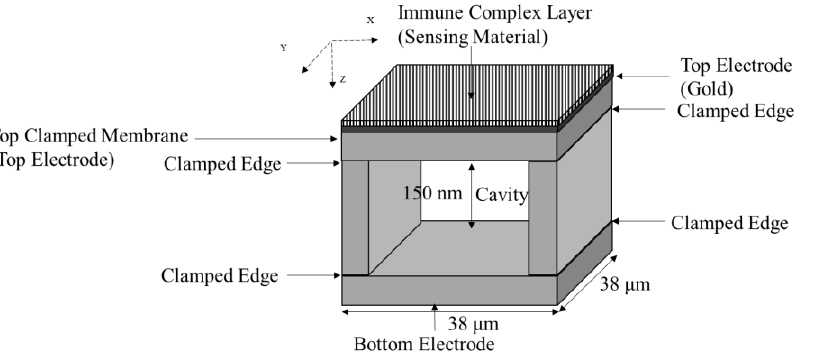
Figure 21. Schematic view of a square capacitive clamped membrane structure (image not to scale).